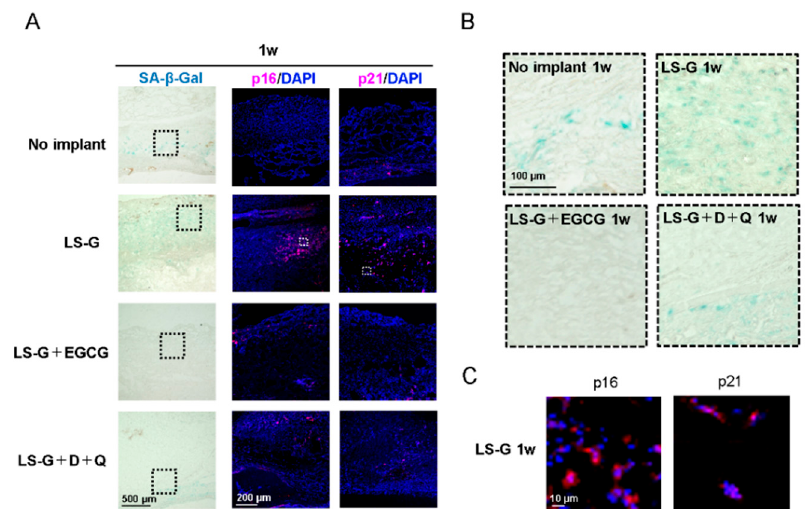
Figure 4. Detection of cellular senescence in bone defects one week after surgery. Low ( A ) and high ( B ) magnification microscopic images of bone defects stained with SA- β -gal or with antibodies for p16 and p21. ( C ) Representative magnified images of senescent cells induced by LS-G. Broken lines in ( A ) show magnified area for ( B ). White squares in ( A ) show magnified area for ( C ). D, Dasatinib; Q, Quercetin; LS-G, implantation of LPS-sustained gelatin sponges in bone defects; LS-G+EGCG, implantation of LS-Gs chemically modified with EGCG in bone defects; LS-G+D+Q, oral administration of D+Q with implantation of LS-Gs in bone defects.